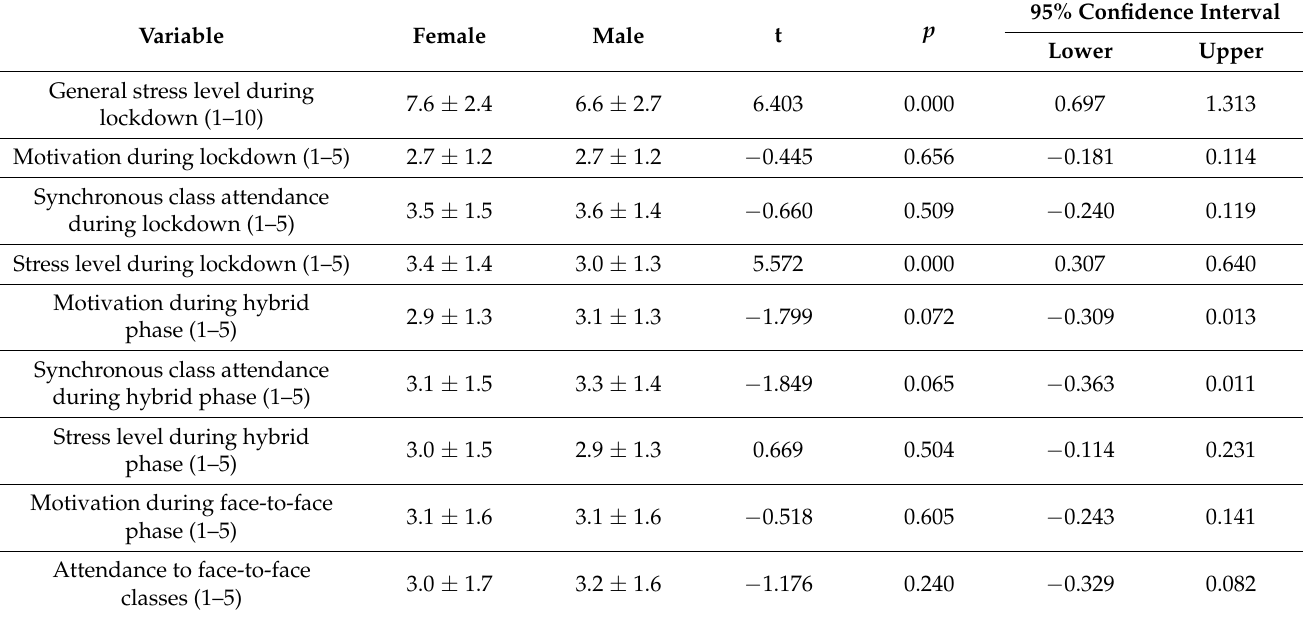
Table 1. Differences between genders in the variables of perception of academic quality during the